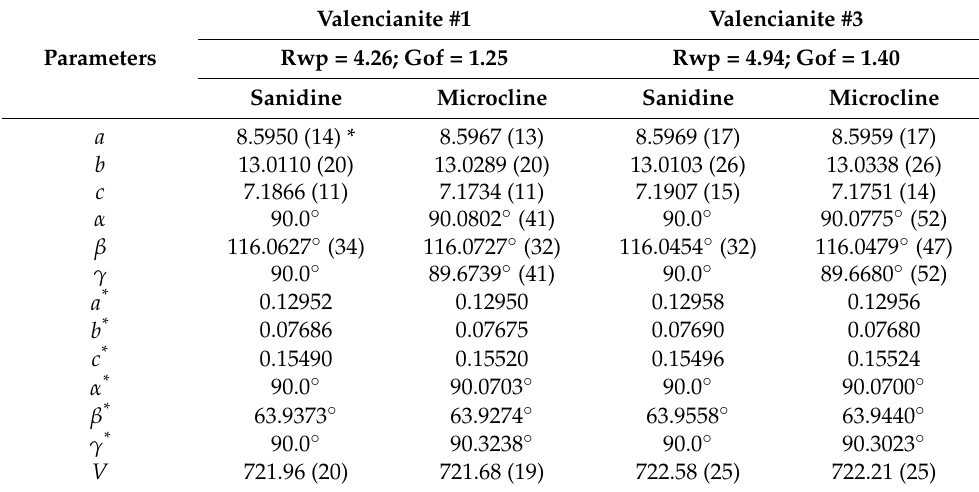
Table 2. Cell parameters for sanidine and microcline phases obtained in the Rietveld refinement of adularia from La Valenciana mine, Guanajuato, Mexico.